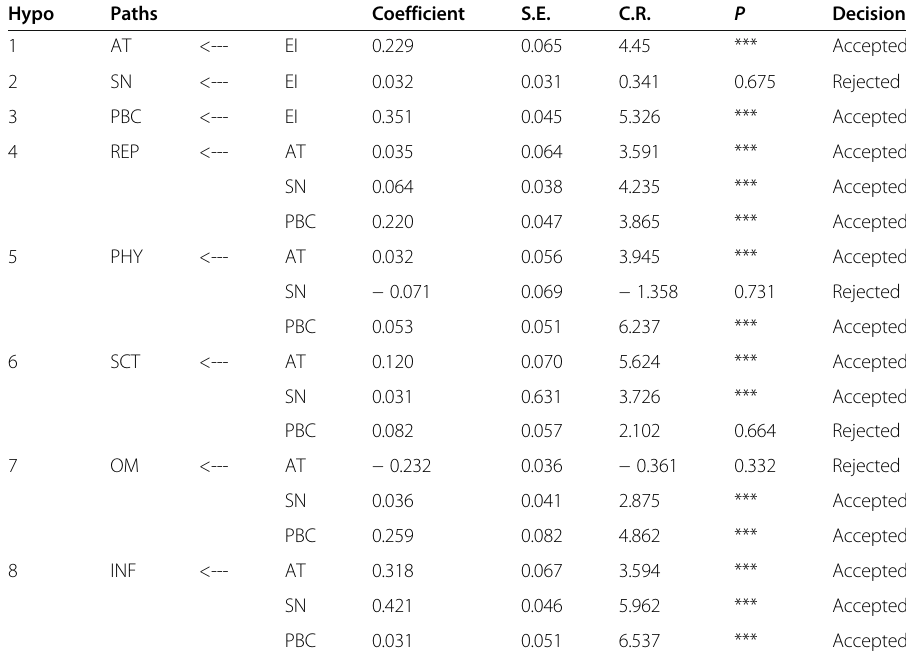
Table 3 Hypothesis test and path